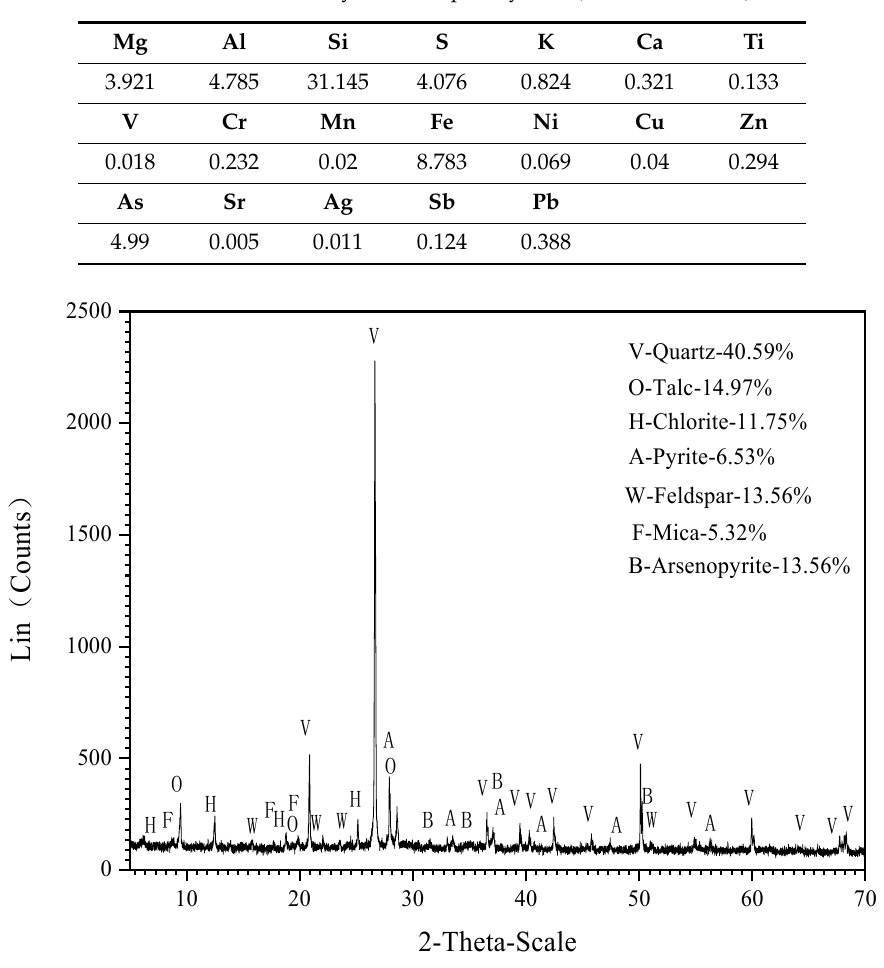
Figure 1. XRD pattern of raw ore.